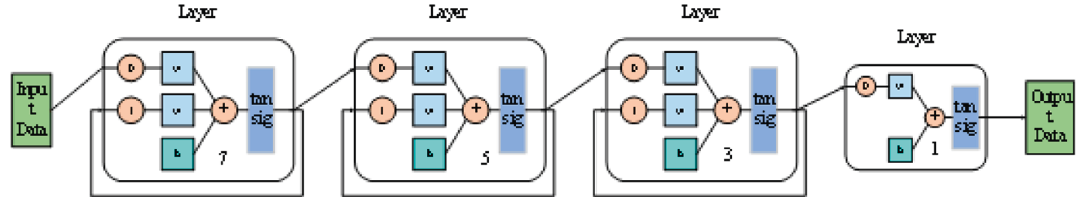
Figure 2: Elman neural network